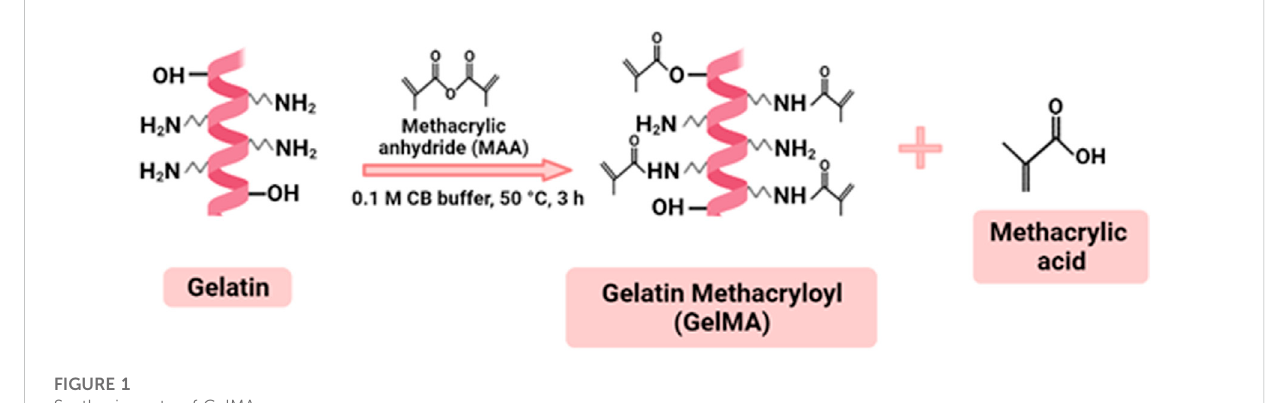
FIGURE 1 Synthesis route of